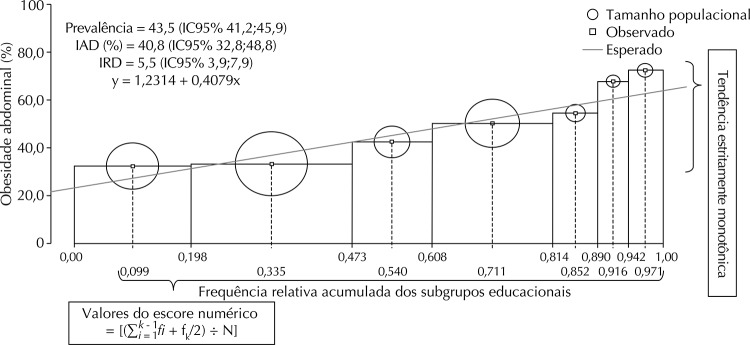
Desigualdade na ocorrência de obesidade abdominal entre os múltiplos grupos educacionais na população feminina. EPS, 1999-2001.